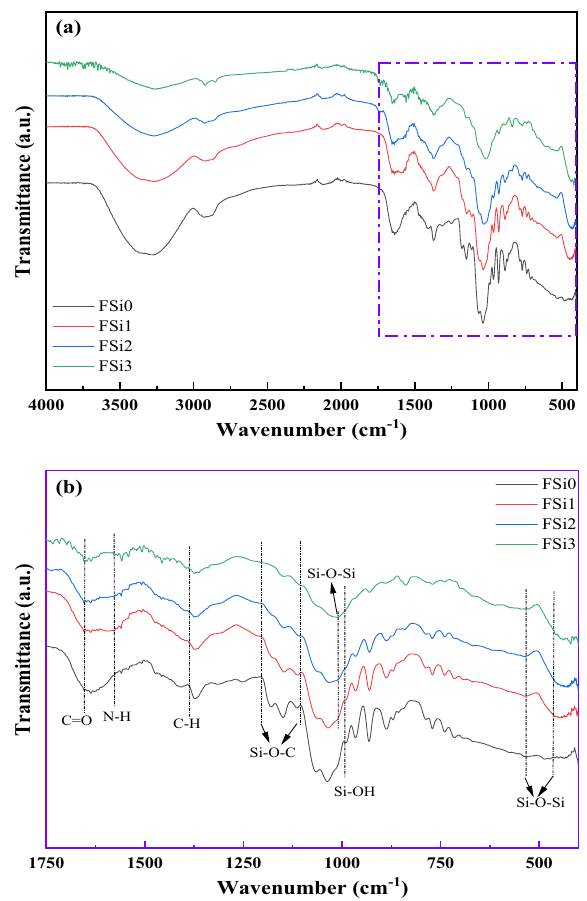
Figure 5. Fourier transform infrared spectroscopy (FTIR) of FSi group of samples ( a ) from 400 to 4000 cm -1 ; ( b ) from 400 to 1750 cm -1